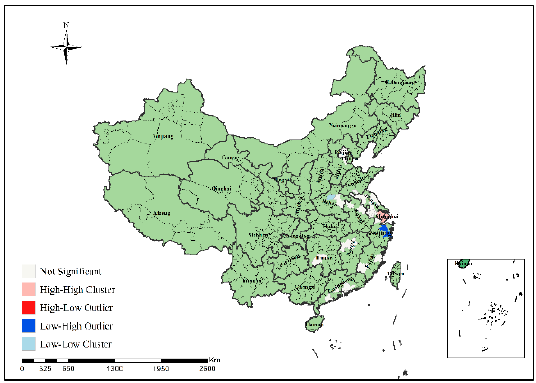
Figure 7. Local spatial autocorrelation analysis results of H7N9 outbreaks in China in 2013.